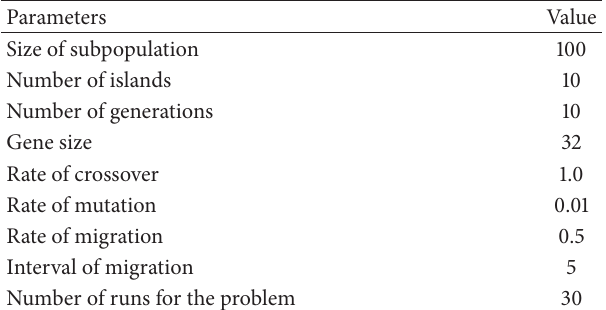
Table 5: The parameter settings of MIGA.